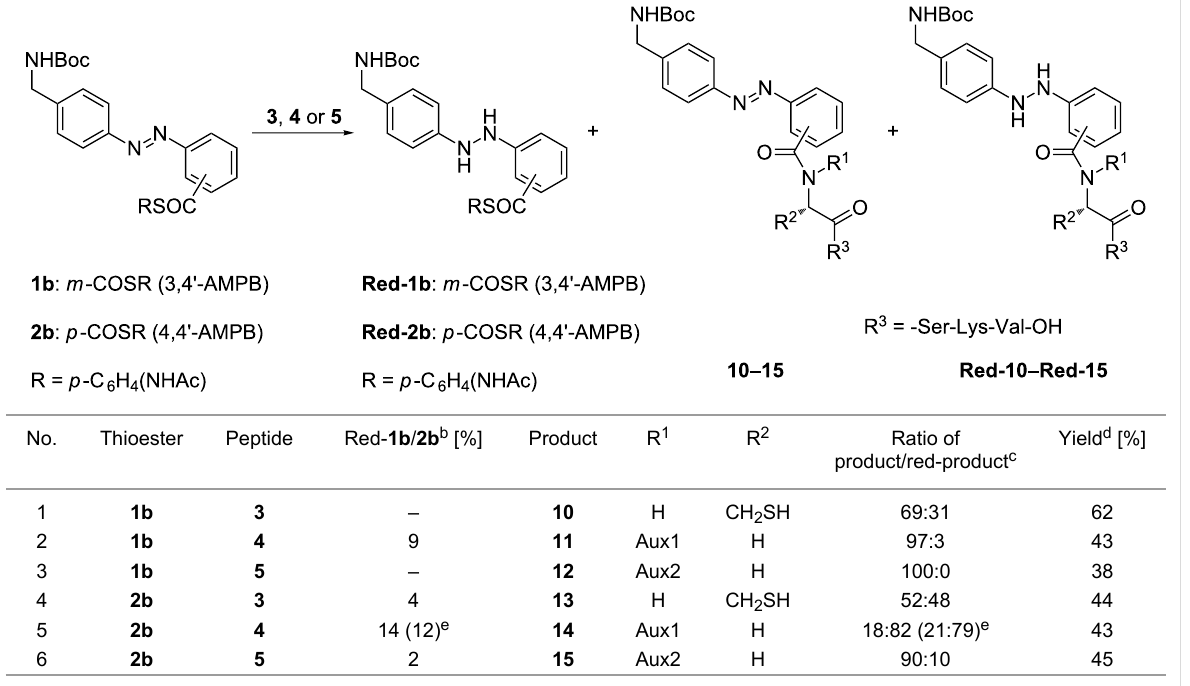
Table 1: Cysteine- and auxiliary-based ligation courses with 3,4'-AMPB thioester 1b and 4,4'-AMPB thioester 2b . a